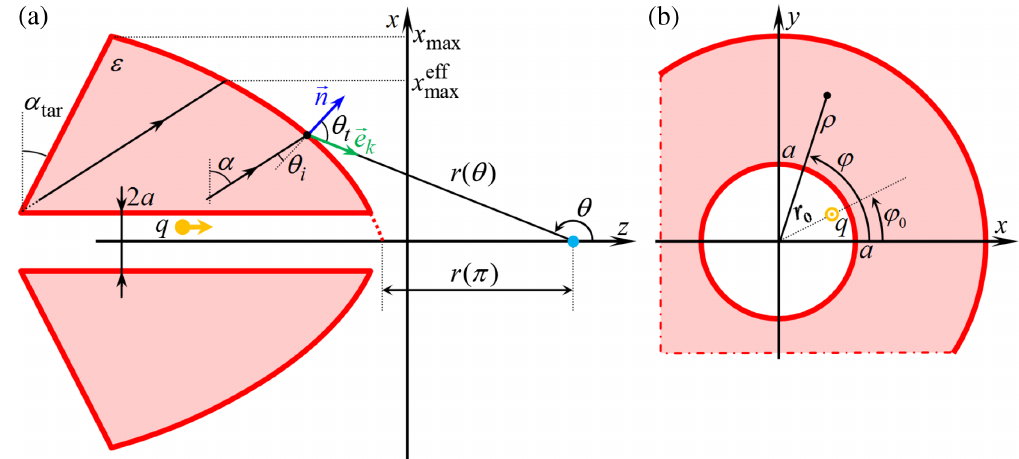
FIG. 1. Geometry of the problem. (a) ð zx Þ -cut of the dielectric concentrator for Cherenkov radiation: the axisymmetric dielectric target with the specific outer profile (determined by the function r ð θ Þ ) and the inner channel of the radius a where the point charge q moves along the straight trajectory shifted with respect to the z -axis. Depicted parameters are discussed in the text. (b) ð xy Þ -cut of the target (the channel radius is enlarged for convenience) and the position of the charge shifted